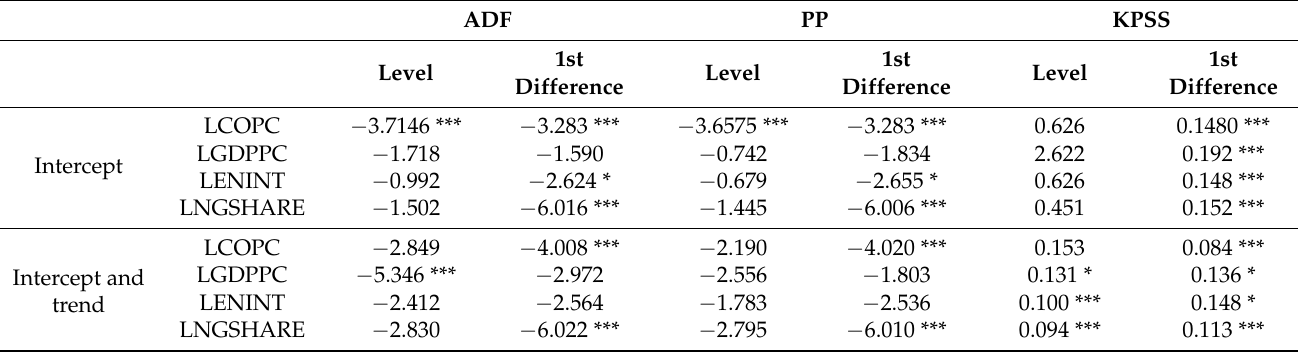
Table 2. Unit root test